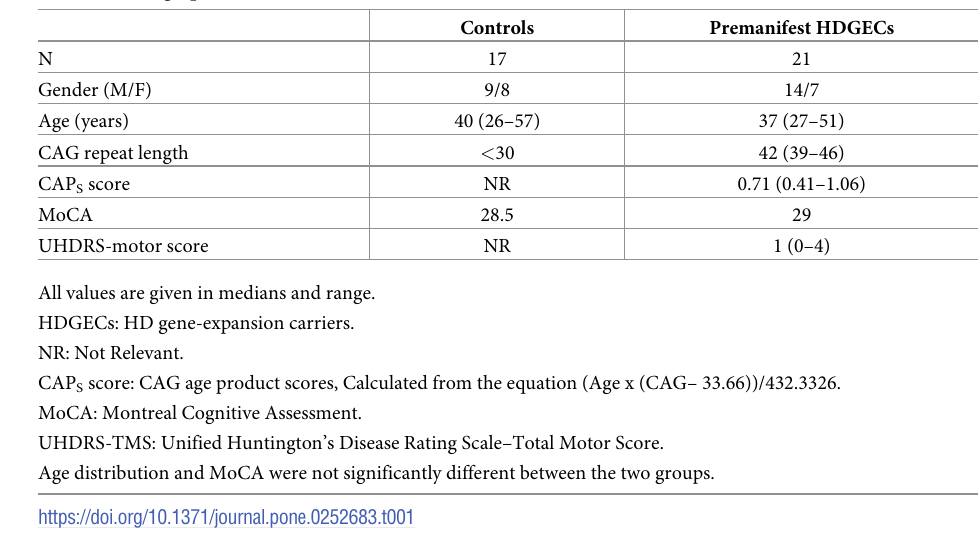
Table 1. Demographic